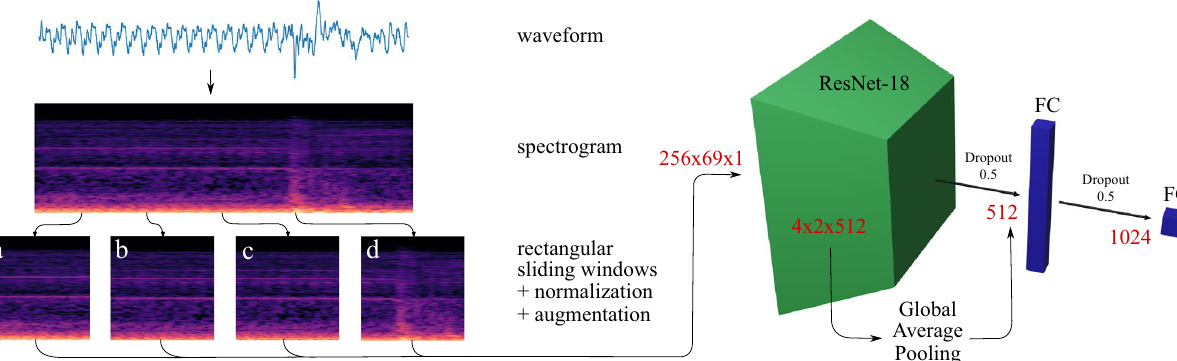
Figure 3. A breakthrough sequence with a total length of about 1 s , taken from the dataset acquired during the cadaver experiments. The raw waveform was split into frames by applying a rectangular sliding window and mel spectrogram features were computed. For better illustration, the spectrograms in this Figure are plotted using a colormap, however, the features used in the implementation of this work are two-dimensional only. Furthermore, the window length is chosen arbitrarily for better visualization and is not representative for the windows which have been evaluated in this work and are much shorter. Frames ( a ) to ( c ) correspond to the non- breakthrough class, in frame ( d ) the breakthrough event is present and visible in the spectrogram. The features were normalized and augmented which is described in detail in the section “Pre-processing, feature extraction, data augmentation”. A modified ResNet-18 41 architecture, which is introduced in the section “Deep learning model and training”, was implemented to classify breakthrough events from spectrogram features. The output dimensions of each pipeline stage are given in red